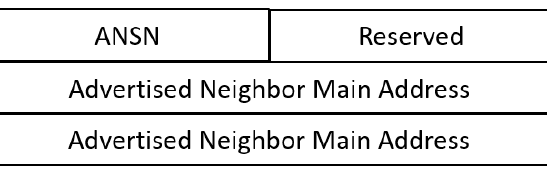
Figure 2. HELLO Message Format (RFC 3626–OLSR).